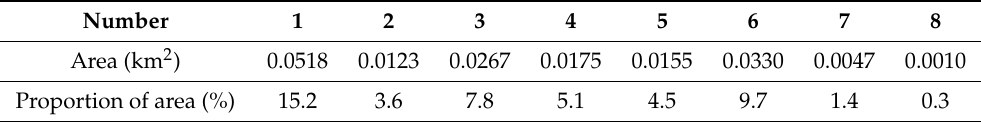
Table 3. Foundation parameters of multistage